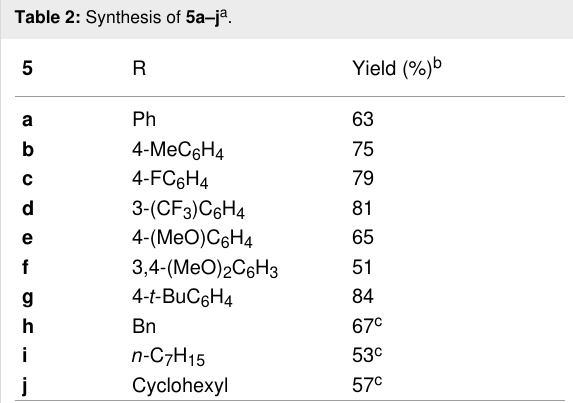
Table 2: Synthesis of 5a–j a .